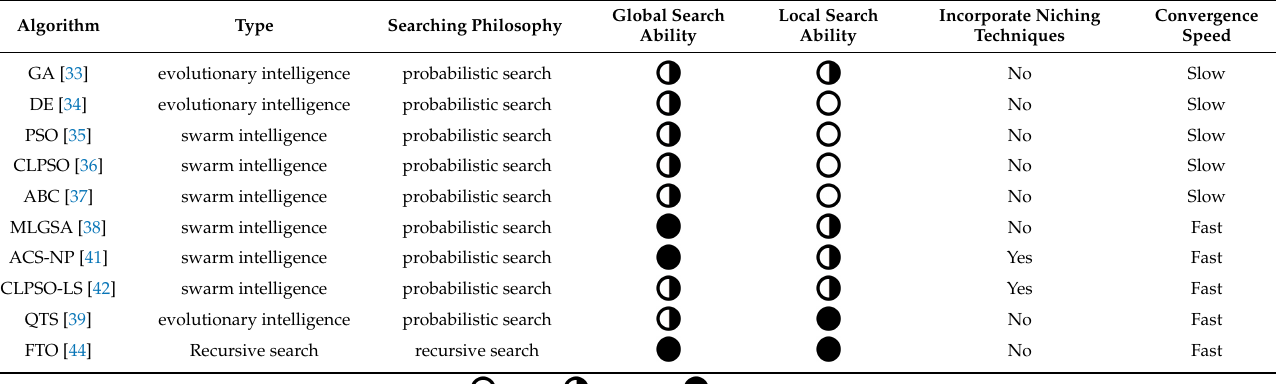
Table 3. Comparison of some optimization algorithms.